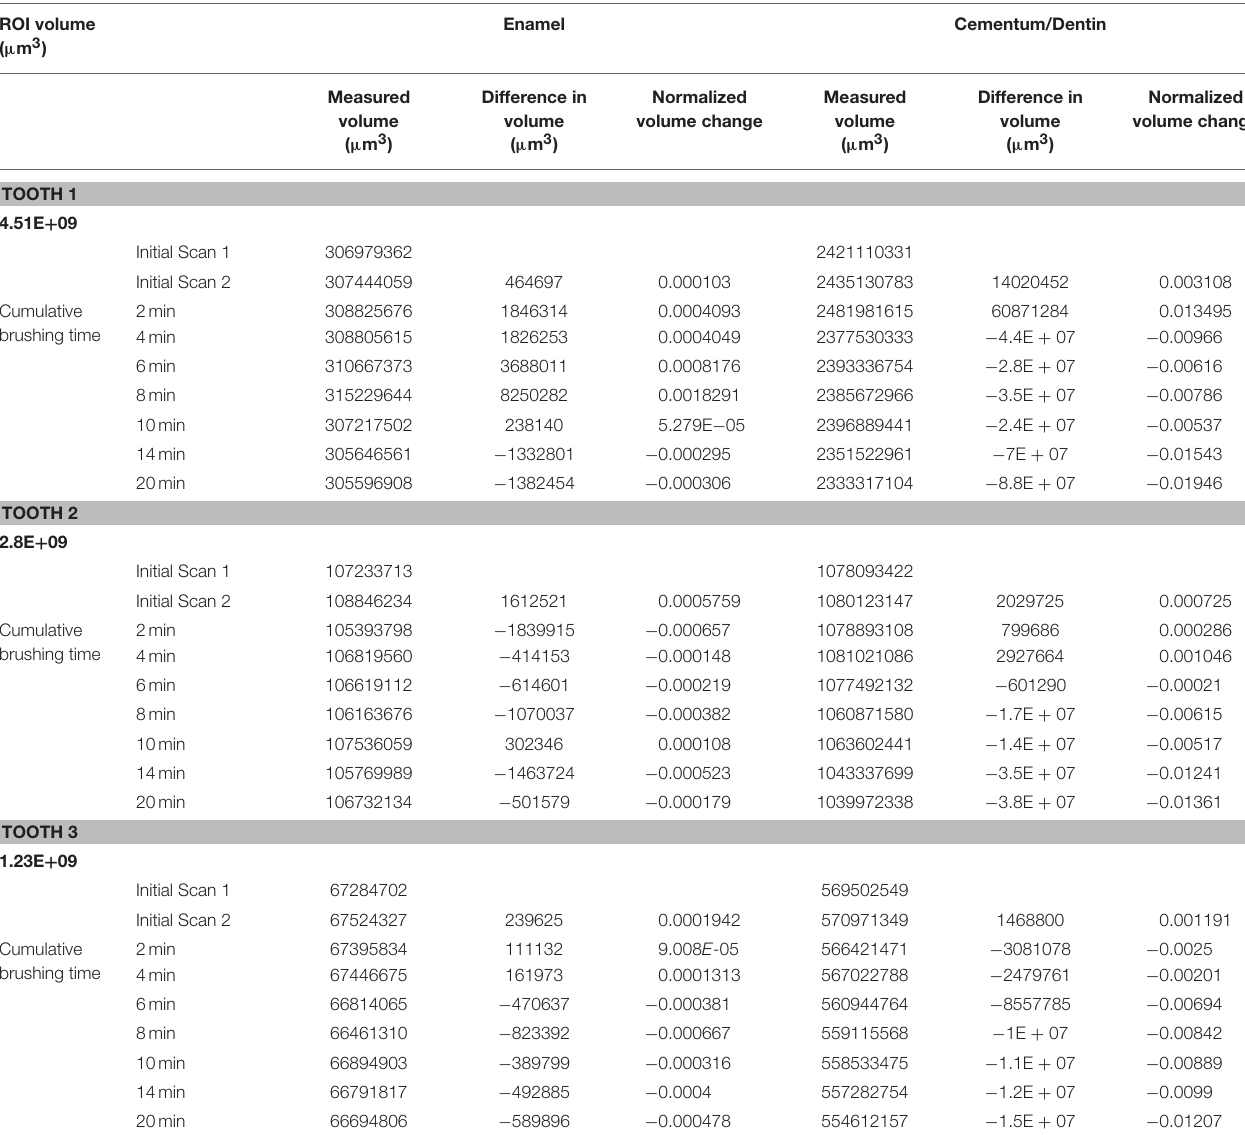
TABLE 1 | List of the volumetric data calculated from the XCT images captured for each tooth sample over 10 brushing time points. ROI volume ( µ m 3